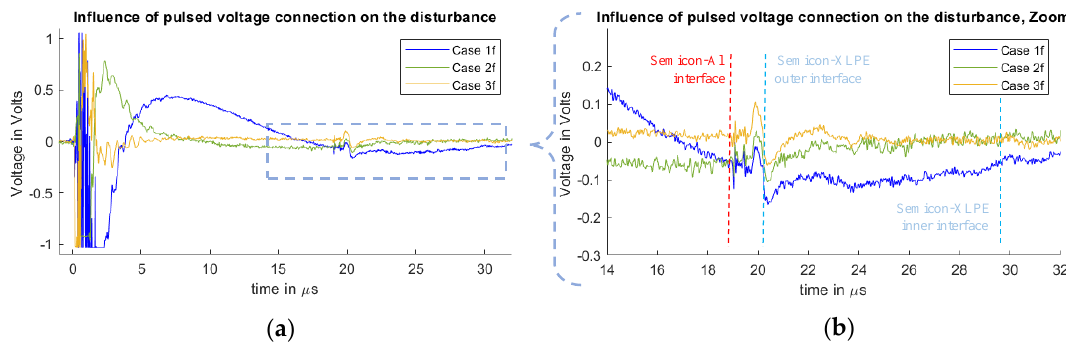
Figure 7. Measured disturbance from Cases 1f, 2f and 3f. ( a ) Full measured signal ranging from the instant of the pulsed voltage application up to 32 µs. ( b ) Zoom to the time instant of the acoustic signal arrival belonging to the charge measurements.